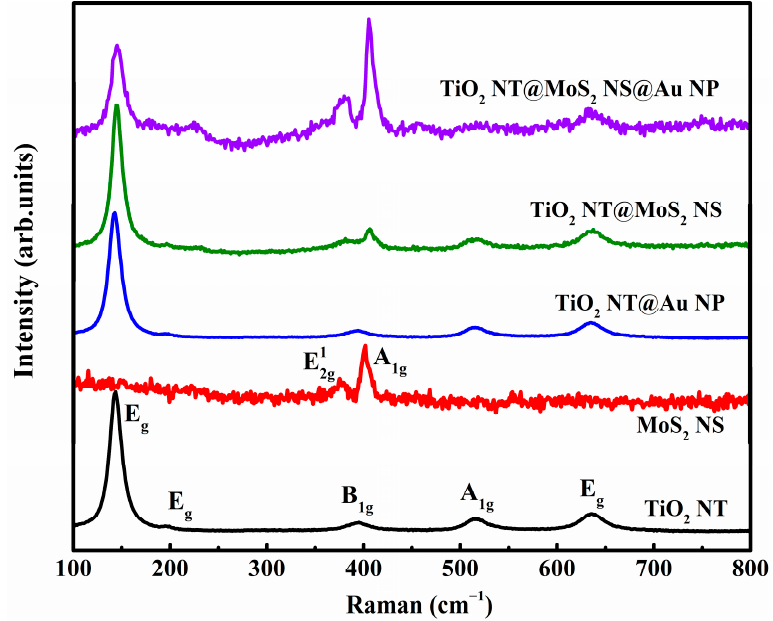
Figure 2. Raman spectra of TiO 2 NT, MoS 2 NS, TiO 2 NT@Au NP, TiO 2 NT@MoS 2 NS, and TiO